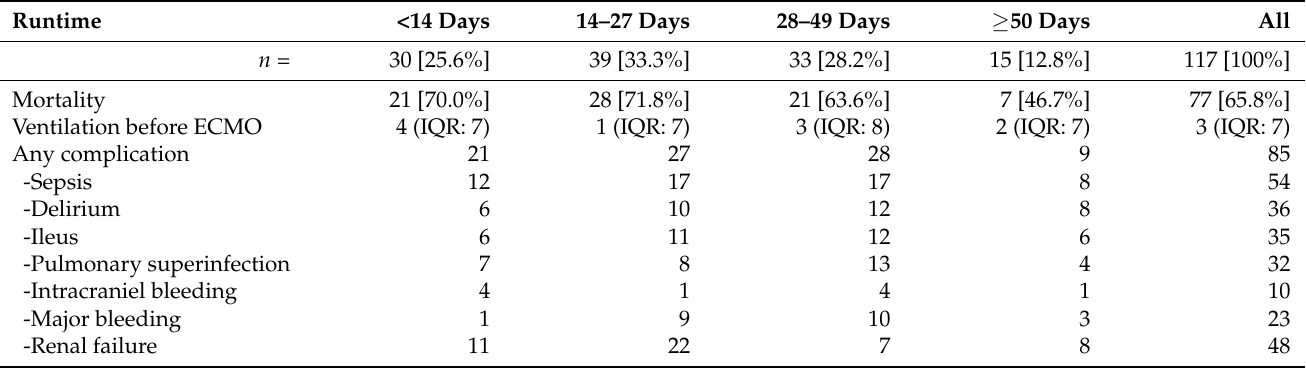
Table 2. Outcome characteristics.